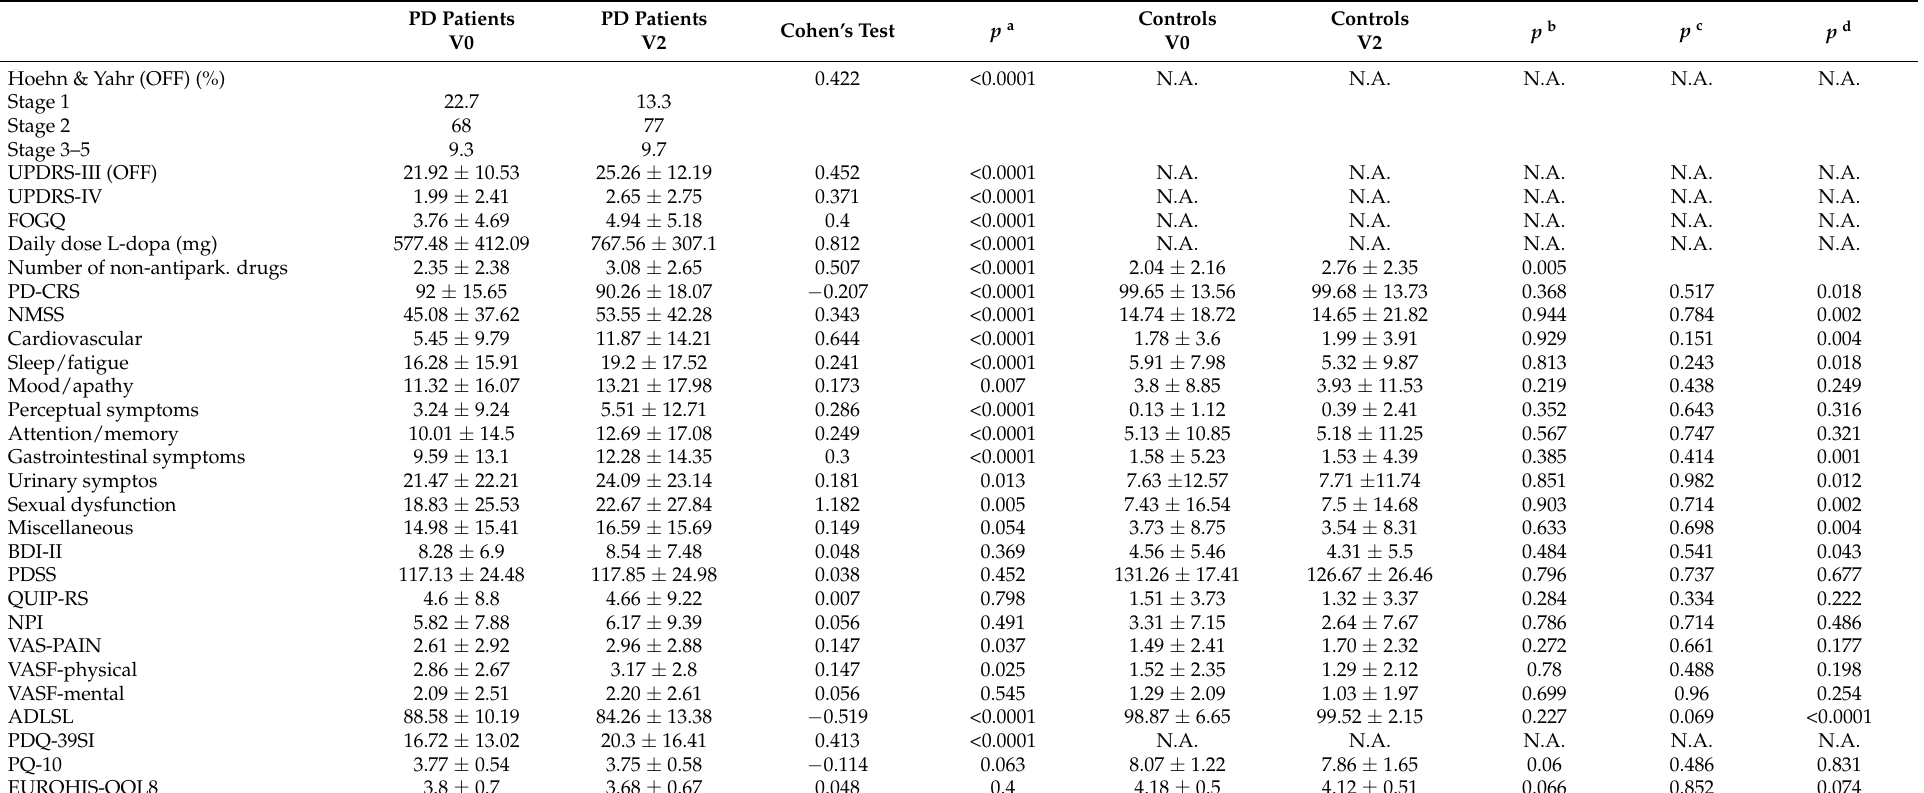
Table 1. Changes in motor and non-motor symptoms, disability, and quality of life in PD patients and/or controls from V0 (baseline) to V2 (2 years ± 1 month). PD Patients